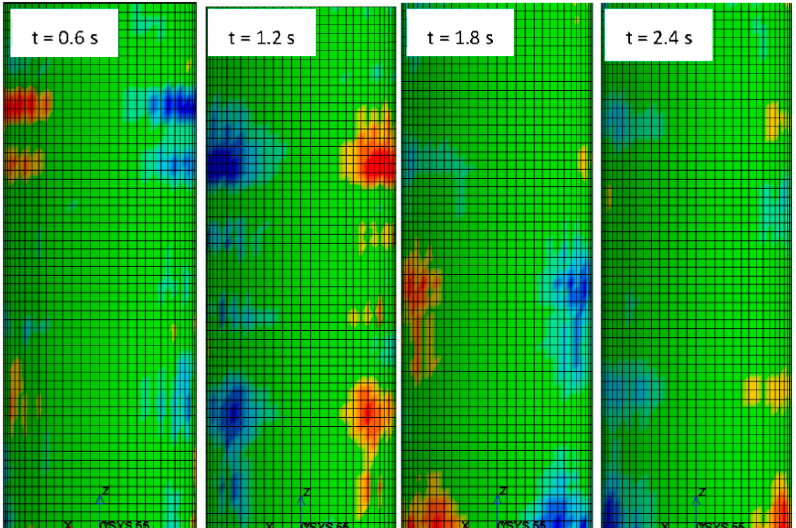
Figure 19. The counter of the radius-displacement when the thickness is 0.01 m, P22.